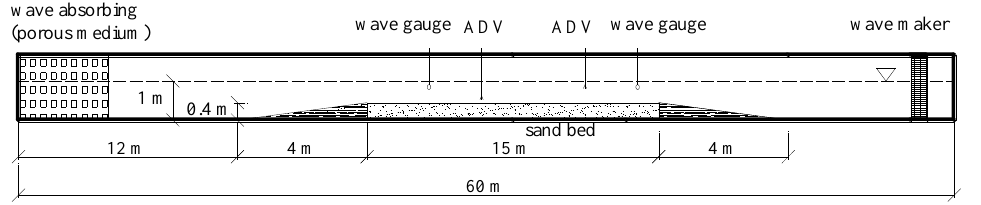
Figure 1. Schematic diagram of model experimental layout.